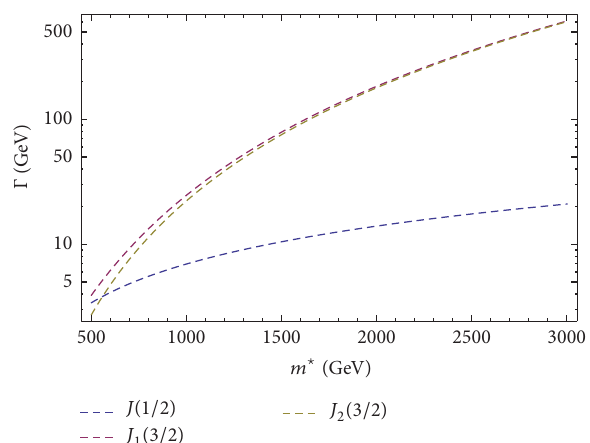
Figure 1: Total decay width of excited neutrinos according to their mass. Here, it is taken as Λ = 𝑚 ⋆ and 𝑓 = −𝑓 󸀠 = 1 for excited spin-1/2 neutrinos and 𝑐 𝑖𝑉 = 𝑐 𝑖𝐴 = 0.5 (𝑖 = 1, 2) for excited spin-3/2 neutrinos for the two phenomenological currents.